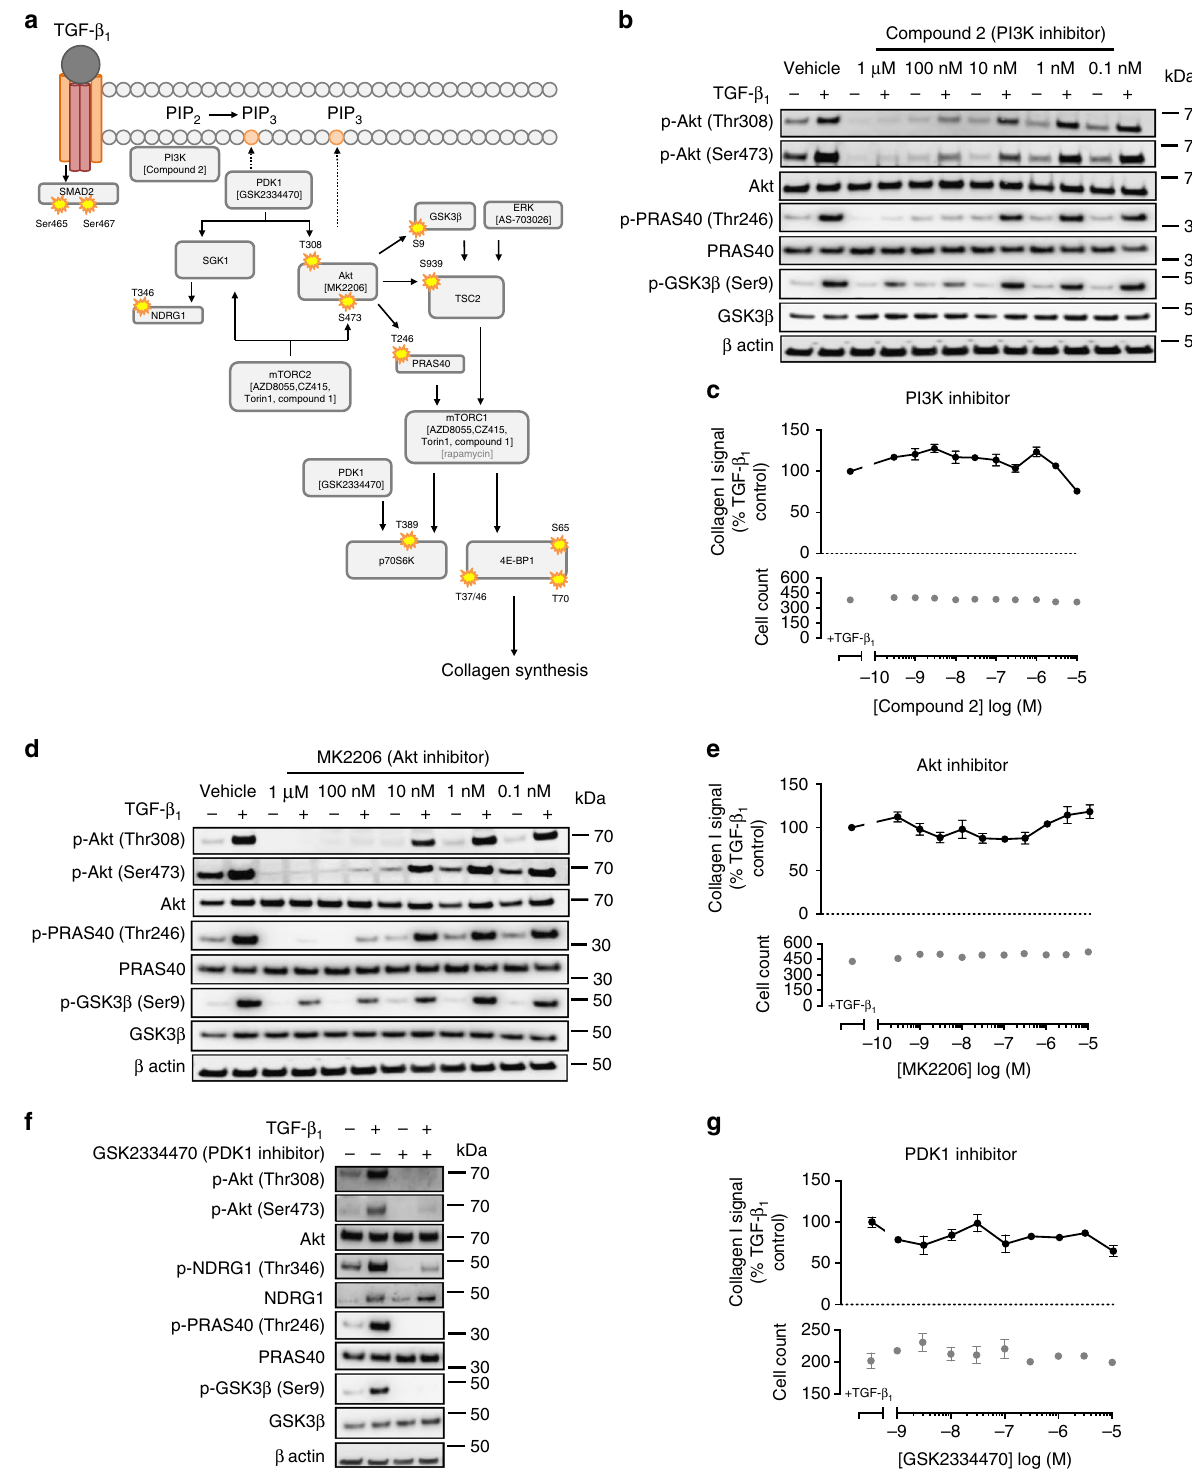
Fig. 2 Inhibition of TGF- β 1 -induced PI3K, Akt, and PDK-1 signaling has no effect on collagen I deposition in pHLFs. A schematic, generated by author J.D.E., of inhibitors and their corresponding target is shown in a . pHLFs were pre-incubated with vehicle (0.1% DMSO) or increasing concentrations of Compound 2, MK2206 or 1 µ M GSK2334470 prior to stimulation with TGF- β 1 (1 ng/ml). Cells were lysed 12 h later and the phosphorylation of speci fi ed proteins was assessed by Western blot ( b , d , f ). Data are representative of 3 independent experiments. Additionally, pHLFs were pre-incubated with vehicle (0.1% DMSO) or increasing concentrations of Compound 2 ( c ), MK2206 ( e ), or GSK2334470 ( g ) and stimulated with TGF- β 1 (1 ng/ml) for 72 h with collagen deposition assessed by macromolecular crowding assay. Data are expressed as collagen I signal calculated as a percentage of the TGF- β 1 -treated control ( n = 4 fi elds of view imaged per well) and cell counts obtained by staining nuclei with DAPI. Each data point shown is mean ± SEM ( n = 4) and is representative of 3 independent